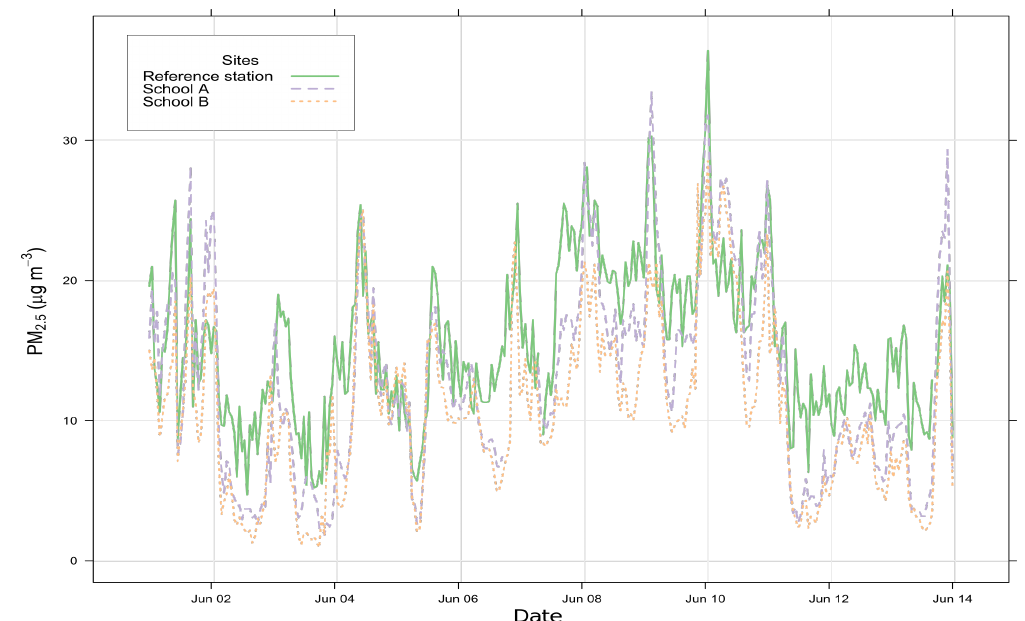
Figure 4. Time series comparing the PM 2.5 concentrations reported by the “Southampton Centre” Automatic Urban and Rural Network (AURN) station [49] and the mean value of the sensors of one Air Quality (AQ) Internet of Things (IoT) device at School A and one device at School B , between 1 June and 14 June